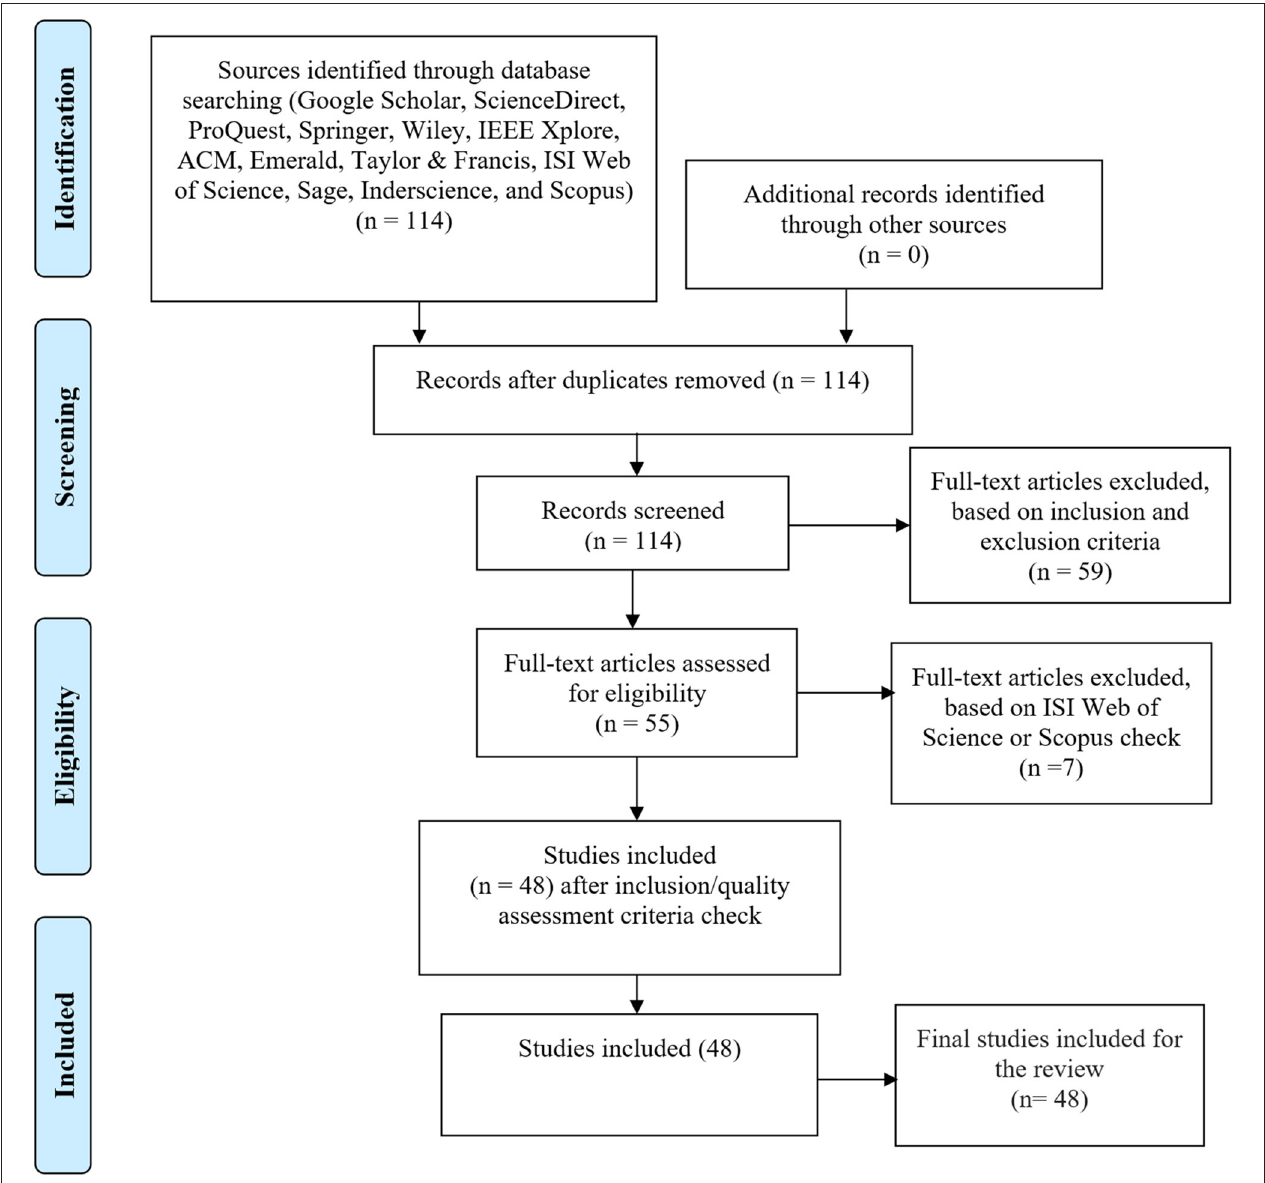
FIGURE 1 | PRISMA flowchart for the selected